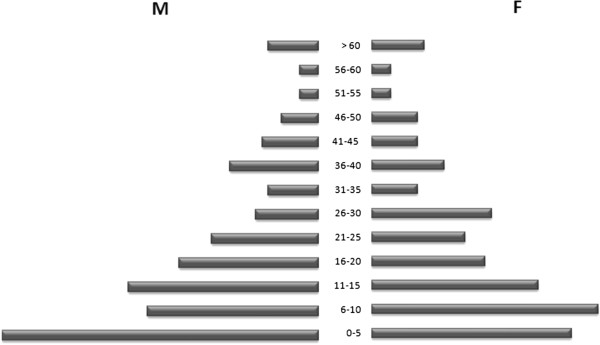
The pyramid of age in Zindarou based on the study population enrolled for the survey in 2007 (441 inhabitants).